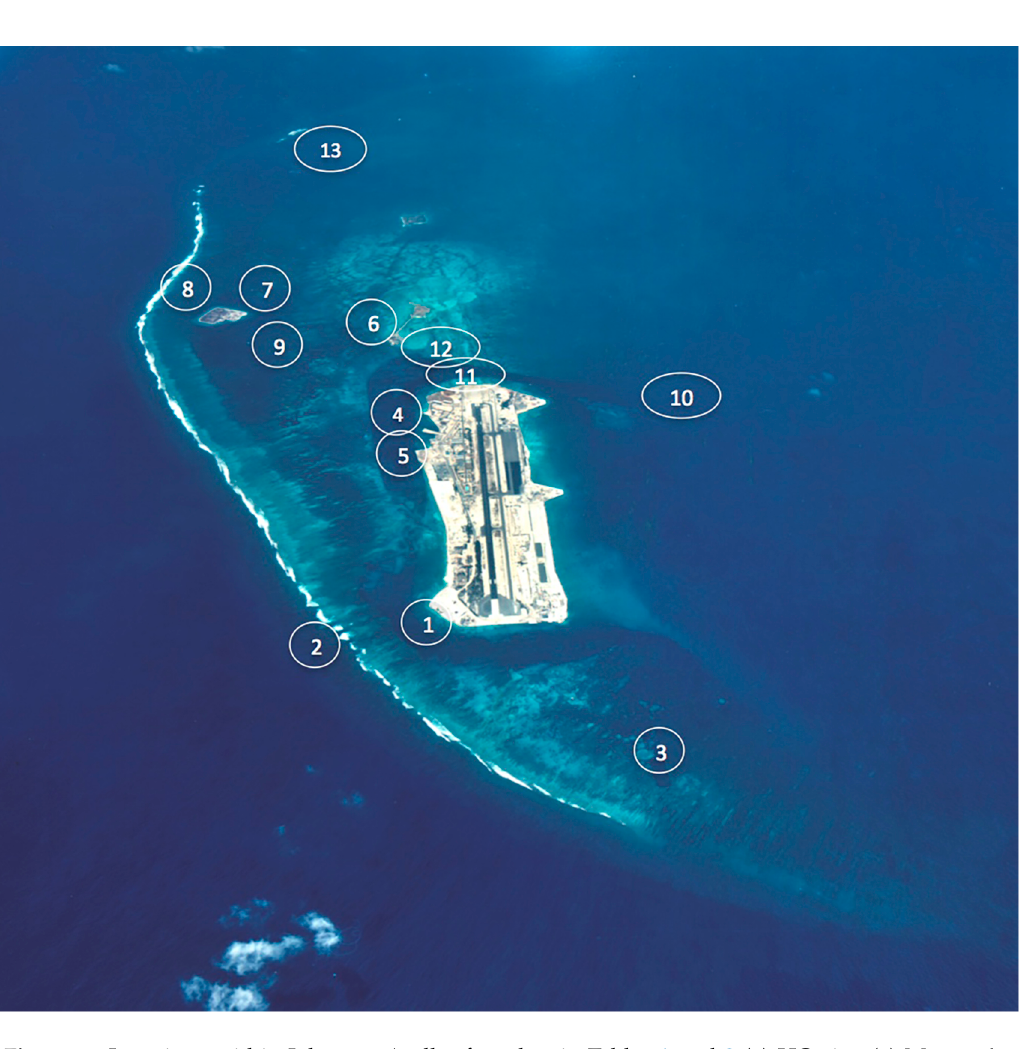
Figure 8. Locations within Johnston Atoll referred to in Tables 1 and 2 ( 1 ) HO site, ( 2 ) Munsen’s gap, ( 3 ) west camera stand, ( 4 ) Navy pier, ( 5 ) boat ramp, ( 6 ) Sand Island wharf, ( 7 ) North Island channel, ( 8 ) North Island back reef, ( 9 ) tugboat shipwreck, ( 10 ) buoy 6, ( 11 ) buoy 13, ( 12 ) buoy 14, ( 13 ) Donovan’s reef.